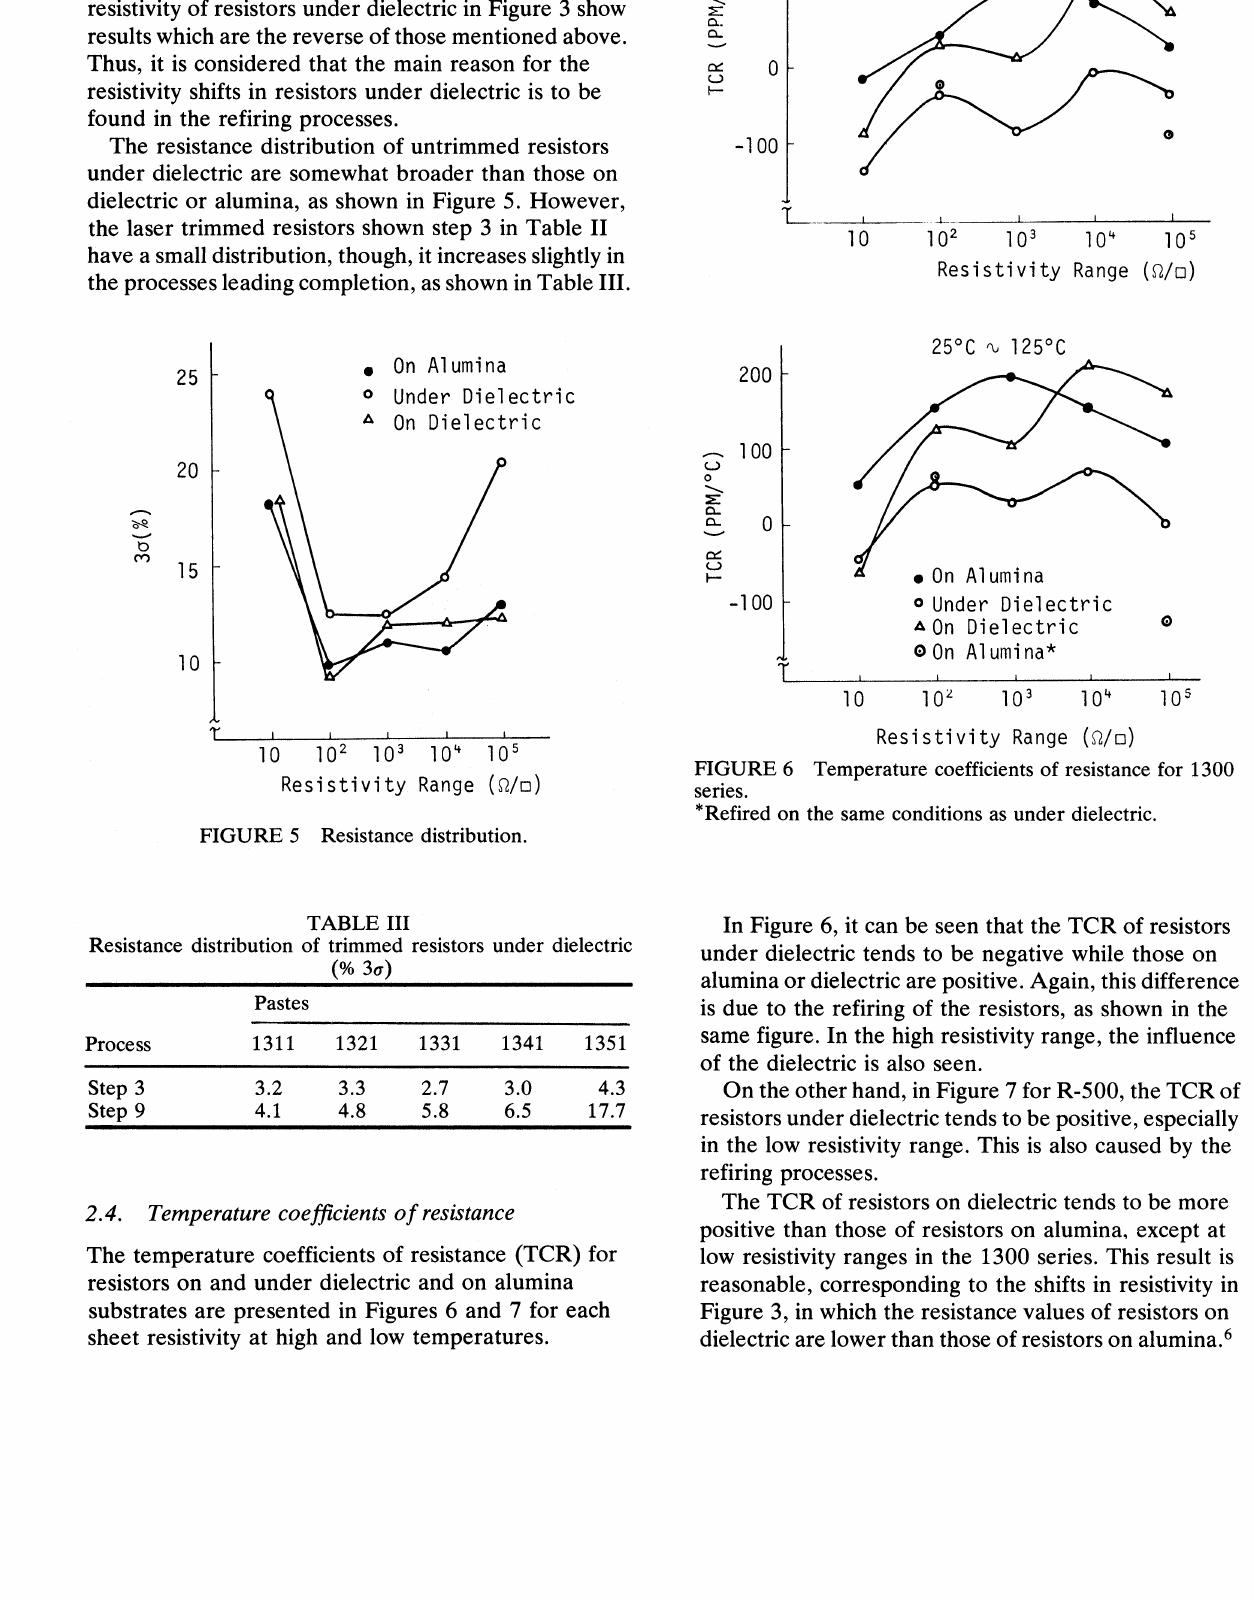
FIGURE 5 Resistance distribution.